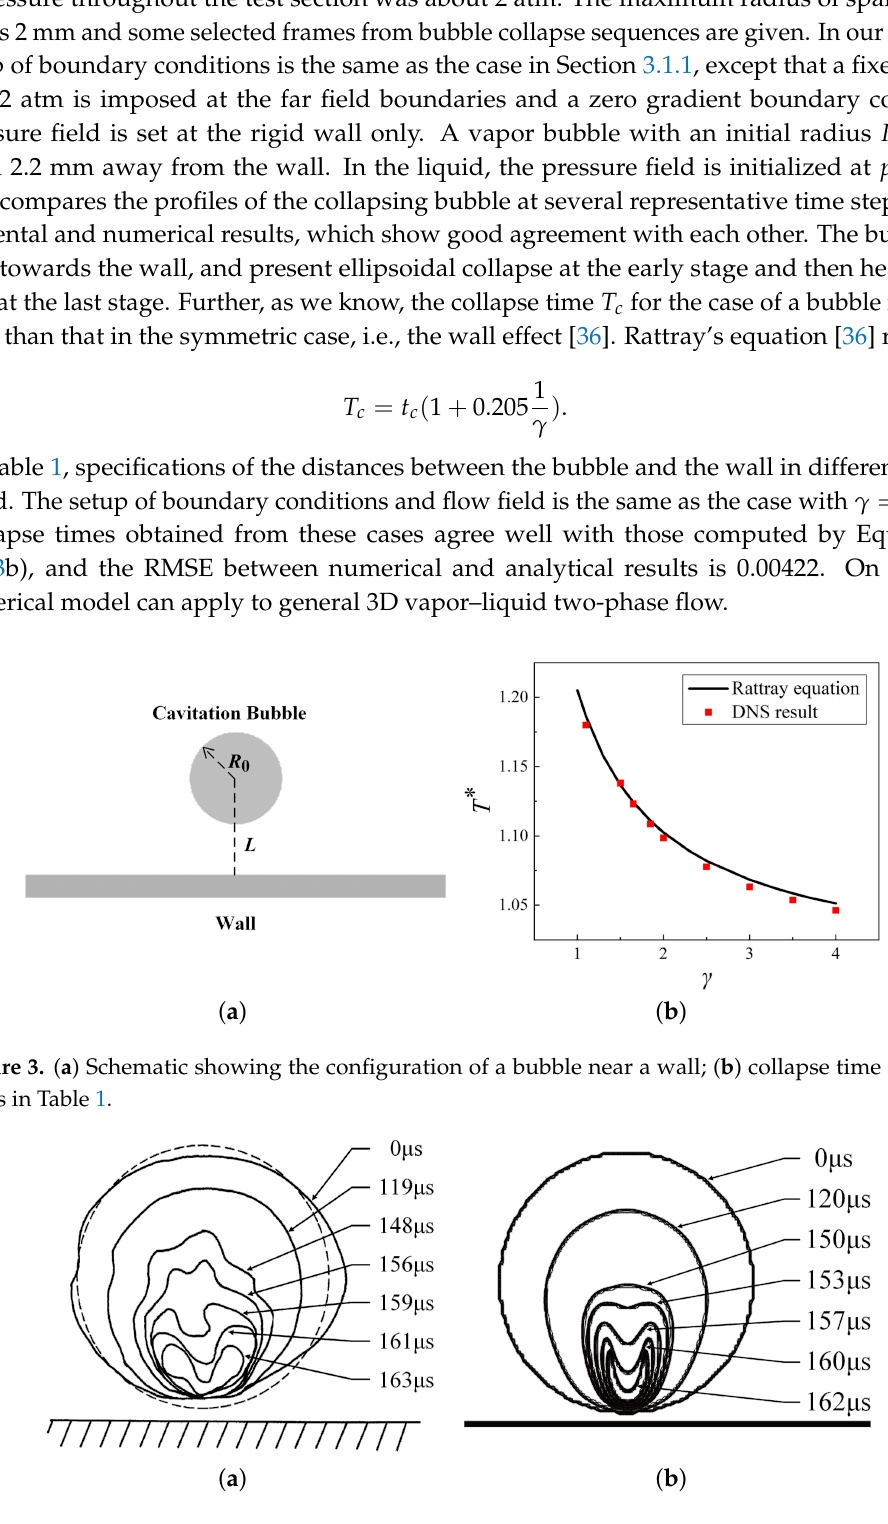
Figure 4. Variations of the profile of a collapsing bubble for the case γ = 1.10: ( a ) results of the experiment [35]; ( b ) results of the